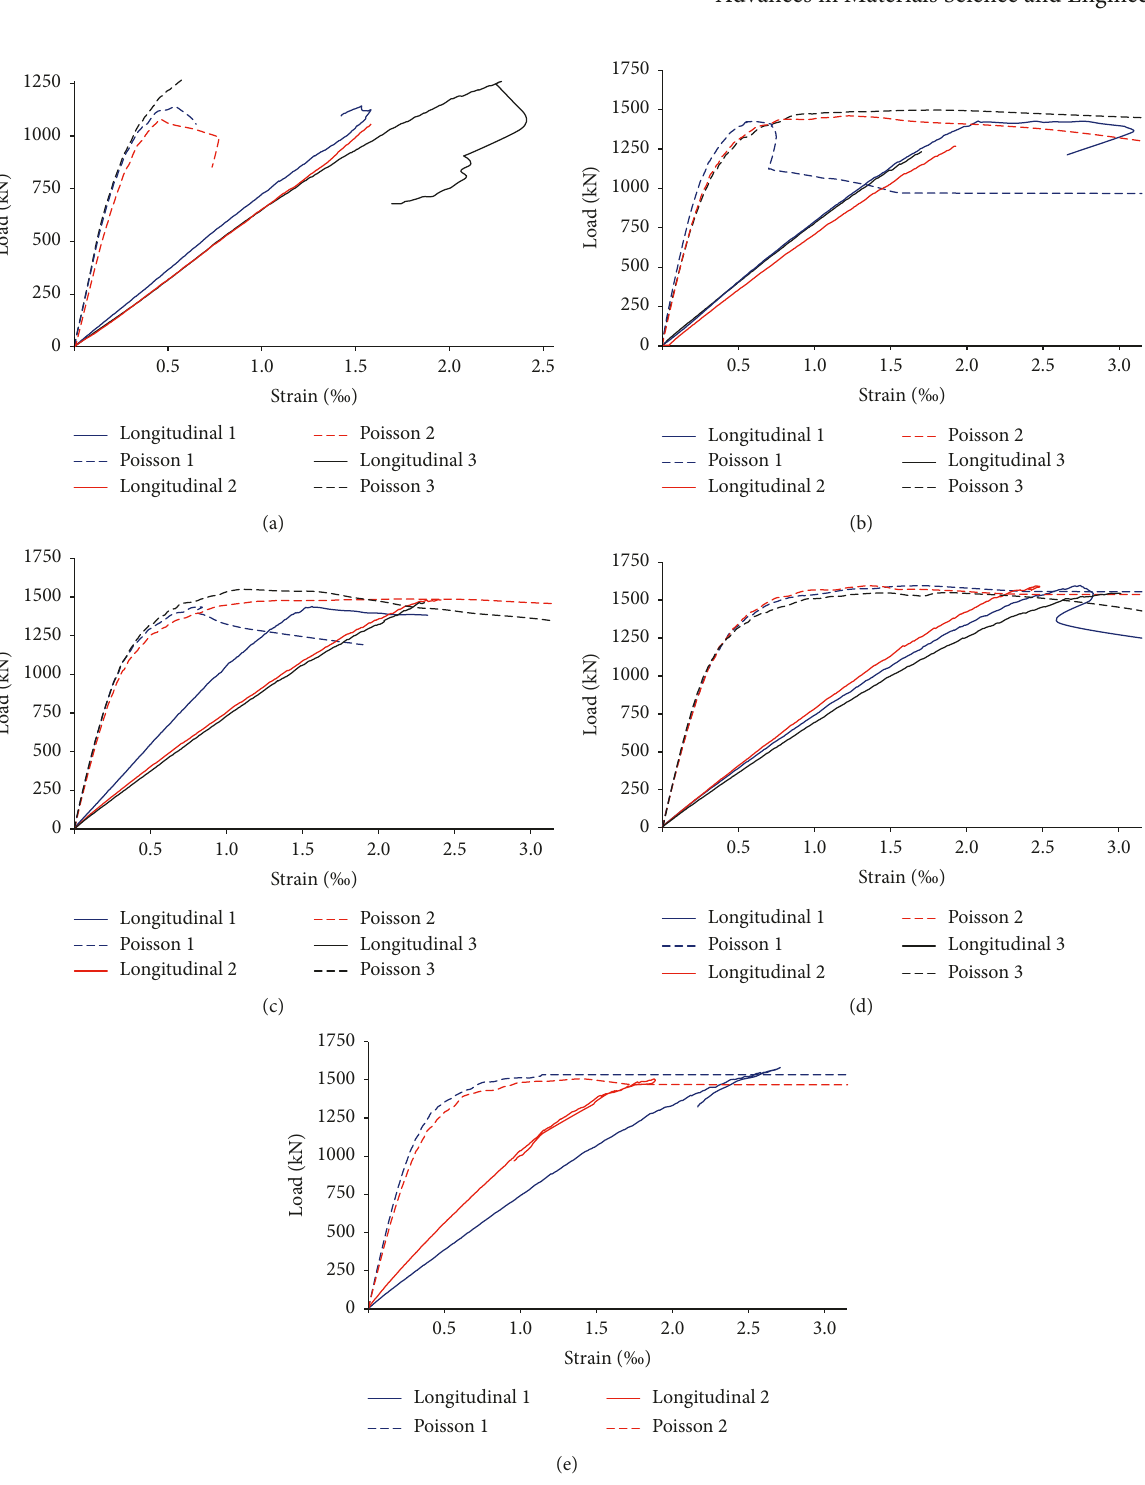
0; (b) FWR 20 kg/m 3 ; (c) FWR (cid:31) (cid:31)